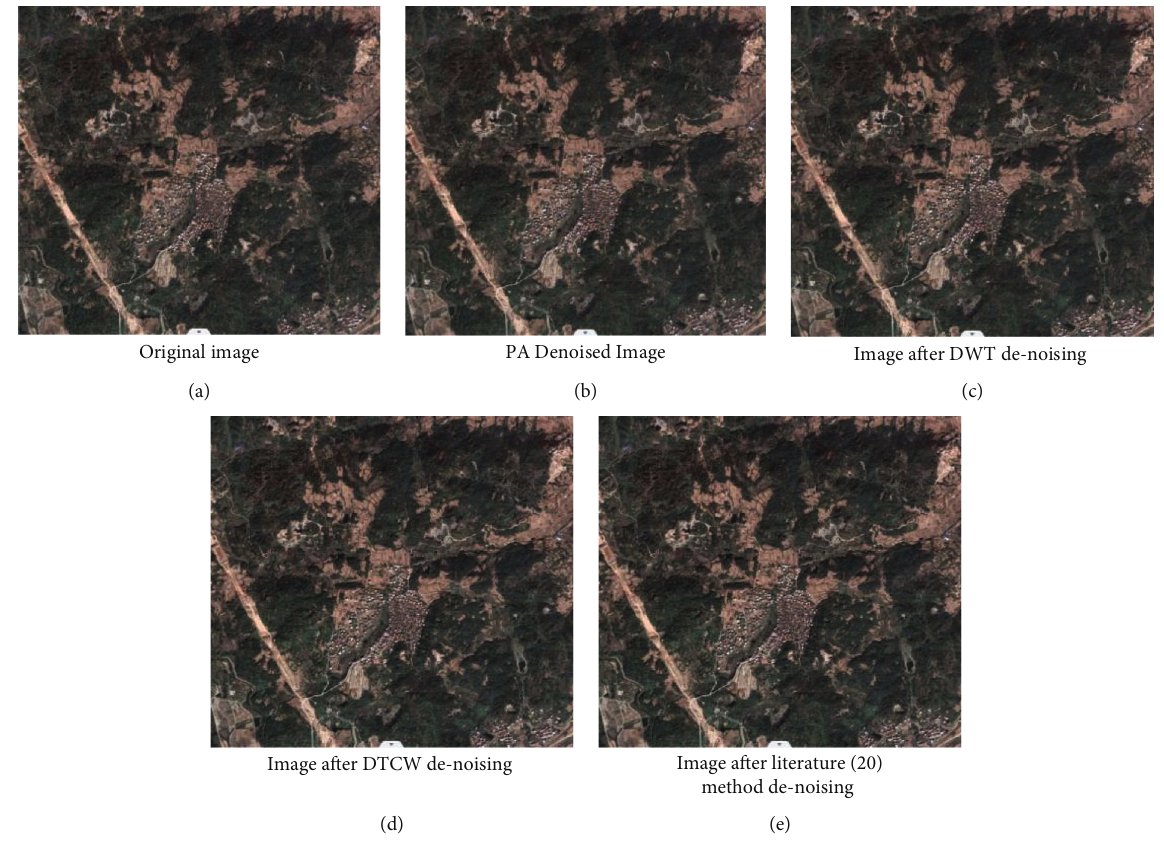
Figure 6: Example of satellite remote sensing image